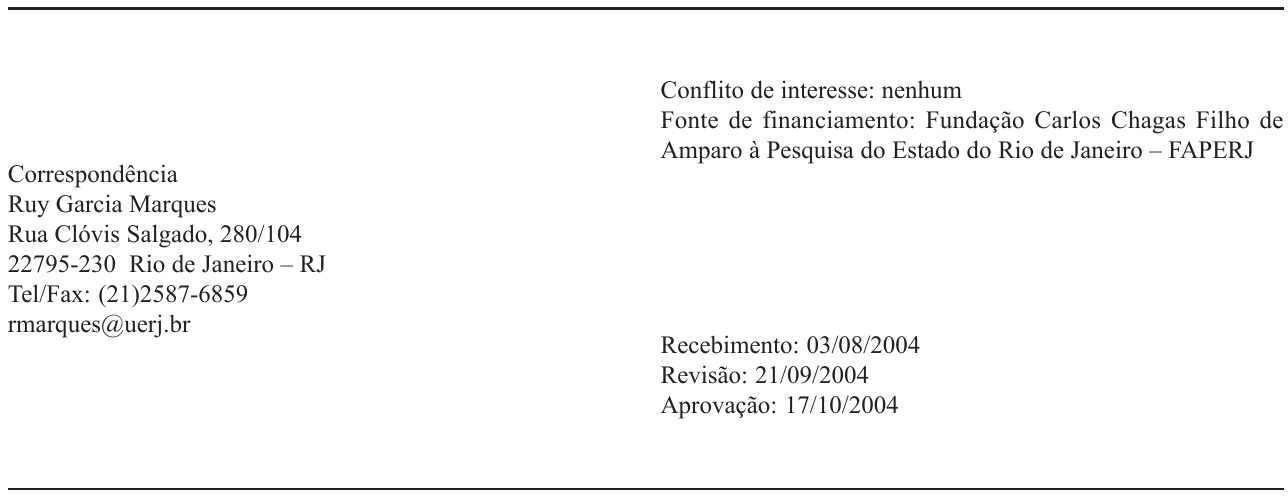
*Figuras coloridas disponíveis em